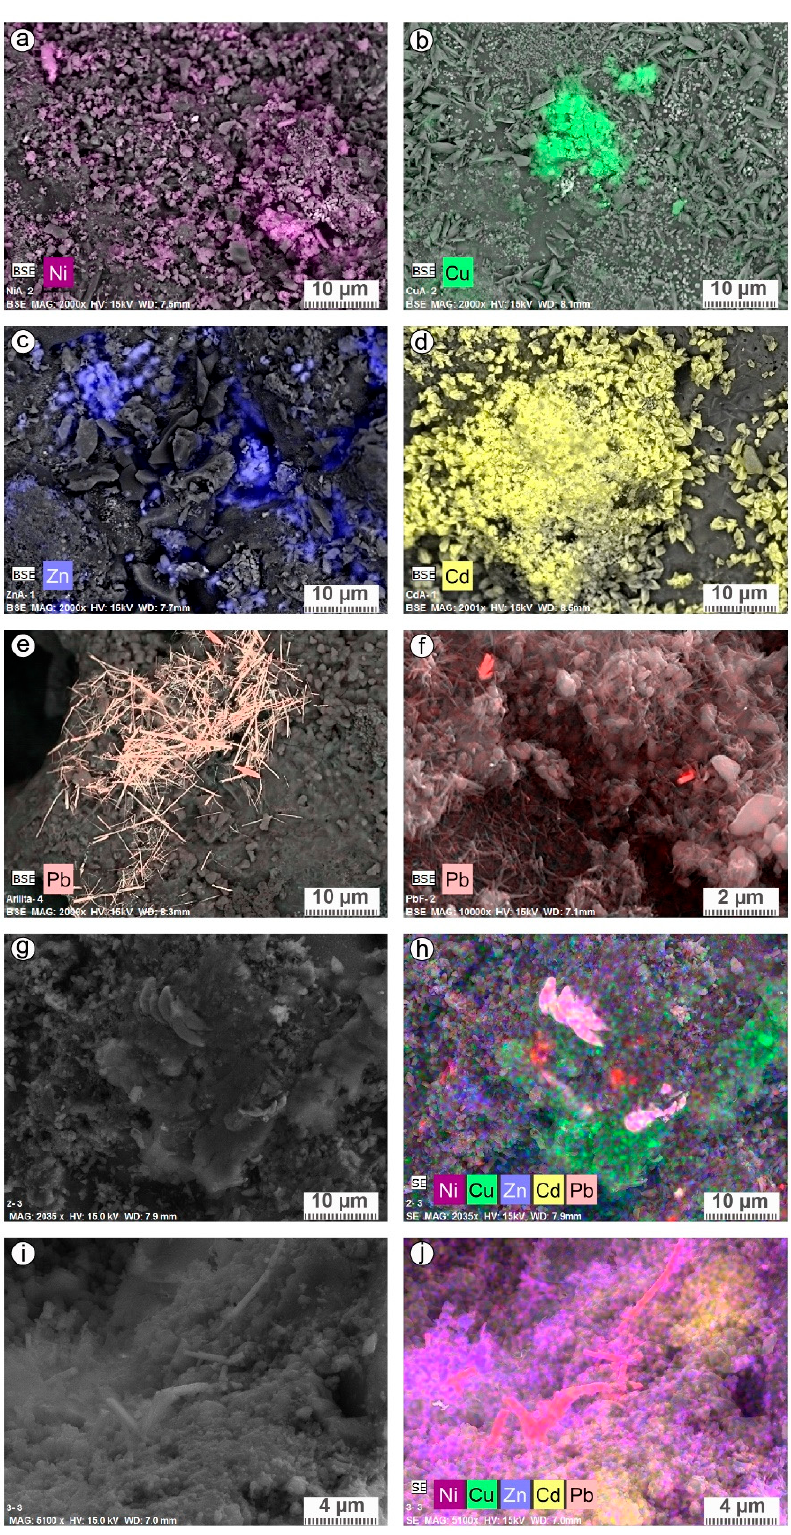
Figure 8. Field-emission scanning electron microscopy (FESEM) images and distribution map (mapping) of the different studied elements after batch experiments with the most concentrated solutions. Images show the forming precipitates on the particles from the batch tests containing solutions with individual contaminants (Arlita: ( a – e ); Filtralite: ( f )) and with multielemental solutions (Arlita: ( g , h ); Filtralite: ( i , j )). The mineralogical composition of the precipitated phases on the LWA surfaces was not determined because they were undetected under XRD. In the experiments, the pres- ence of CO 3 2 − in the solutions was scarce (only from the atmospheric CO 2 ); thus, the pres-